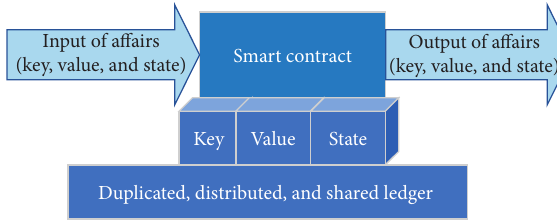
Figure 2: General model of a smart